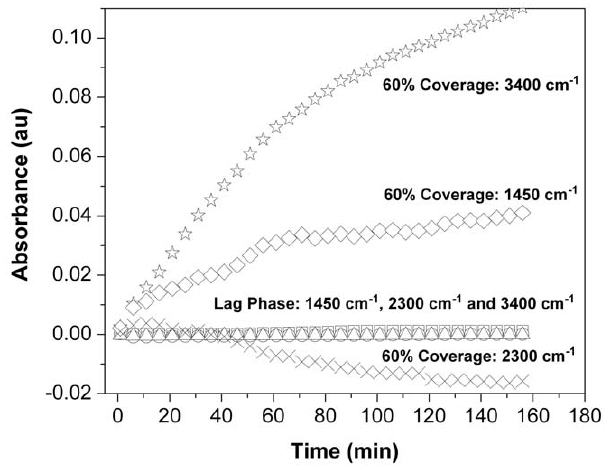
Figure 4. Plot of change in intensity over time of the absorption bands due to H 2 O stretching and bending modes. FTIR spectromicroscopy difference spectra recorded from a sample of lag phase cells (Figure 3) and a sample of cells at 60% coverage (Fig. 2) bathed in DMEM prepared with 100% 2 H 2 O. The first spectrum taken (defined as t =0) is the reference spectrum. 3400 cm 2 1 = 1 H-O- 2 H stretch; 1450 cm 2 1 = 1 H-O- 2 H bend; 2300 cm 2 1 = shoulder of 2 H-O- 2 H stretch; ( q ) 60% Coverage Cells: 3450 cm -1 ; ( % ) Lag Phase Cells: 3450 cm -1 ; ( e ) 60% Coverage Cells: 1450 cm 2 1 ; ( # ) Lag Phase Cells: 1450 cm 2 1 ; ( 6 ) 60% Coverage Cells: 2300 cm 2 1 ; ( n ) Lag Phase Cells: 2300 cm 2 1 . For the cells at 60% coverage, the absorptions due to 1 H- O- 2 H increase over time while the absorption due to 2 H-O- 2 H decreases. Those same absorptions in lag phase cells show essentially no change over the course of this experiment.